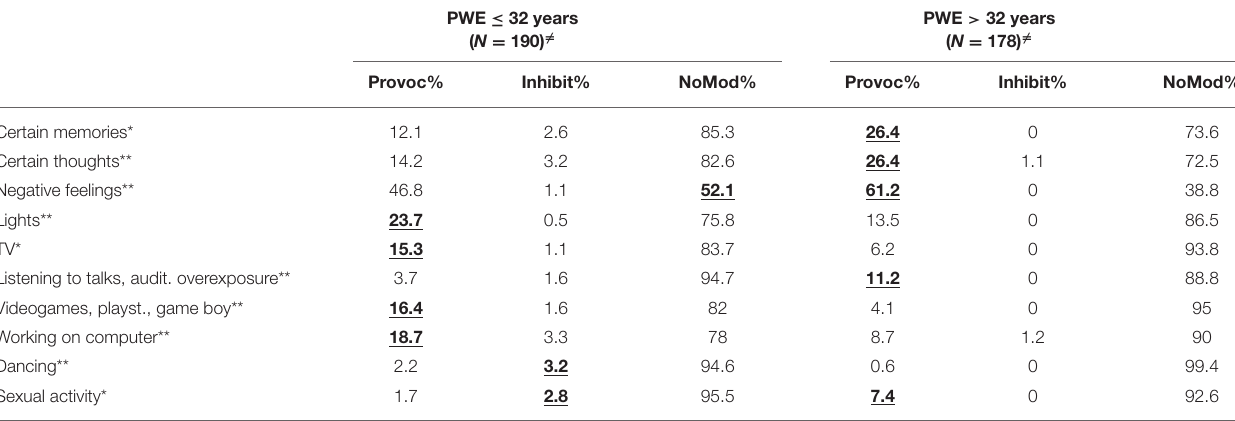
TABLE 4 | Modulatory factors with significant difference between two age groups in epilepsy.